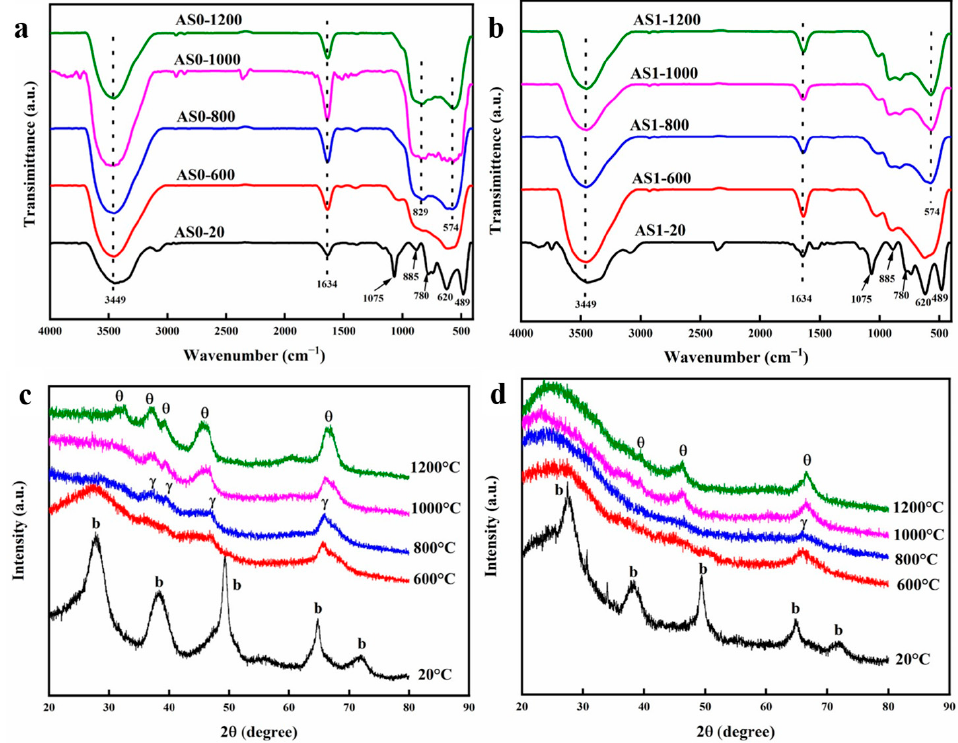
Figure 5. Fourier transform infrared spectrometer (FTIR) of the ( a ) AS0 and ( b ) AS1 after heat Figure 5. FTIR spectra of the ( a ) AS0 and ( b ) AS1 after heat treatment from 20 to 1200 °C; XRD pattern of ( c ) AS0 and ( d ) AS1 after heat treatment from 20 to 1200 °C; all AS samples after heat treatment from 20 to 1200 ◦ C; X-ray diffraction (XRD) pattern of ( c ) AS0 and ( d ) AS1 after heat treatment at 1200 °C. treatment from 20 to 1200 ◦